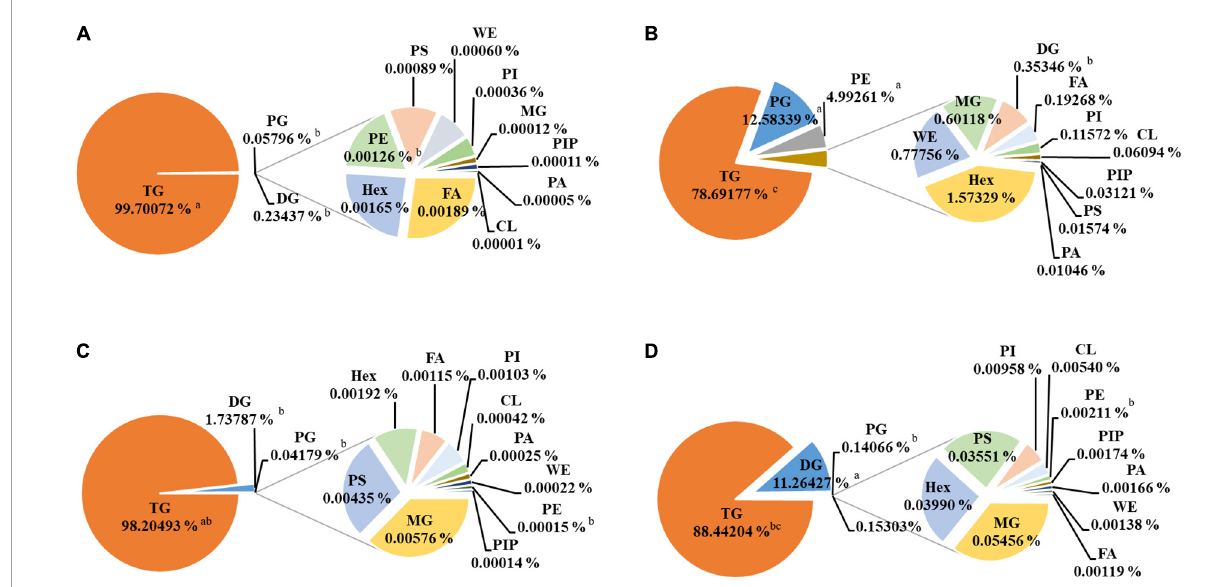
FIGURE2 Composition of EPA/DHA lipids subclasses composition. (A) TG30, (B) TG50, (C) rTG50, (D) rTG70. Data are represented as mean ± SD ( n = 3). Different letters represent significant differences ( p <0.05). Triacylglycerol, TG; diacylglycerol, DG, monoglyceride, MG; phosphatidylglycerol, PG; phosphatidylglycerol, Hex; phosphatidylserine, PS; phosphatidylinositol, PI; cardiolipin, CL; phosphatidylethanolamine, PE; phosphatidylinositol (4) phosphate, PIP; phosphatidic acid, PA; wax exters, WE; fatty acid, FA.